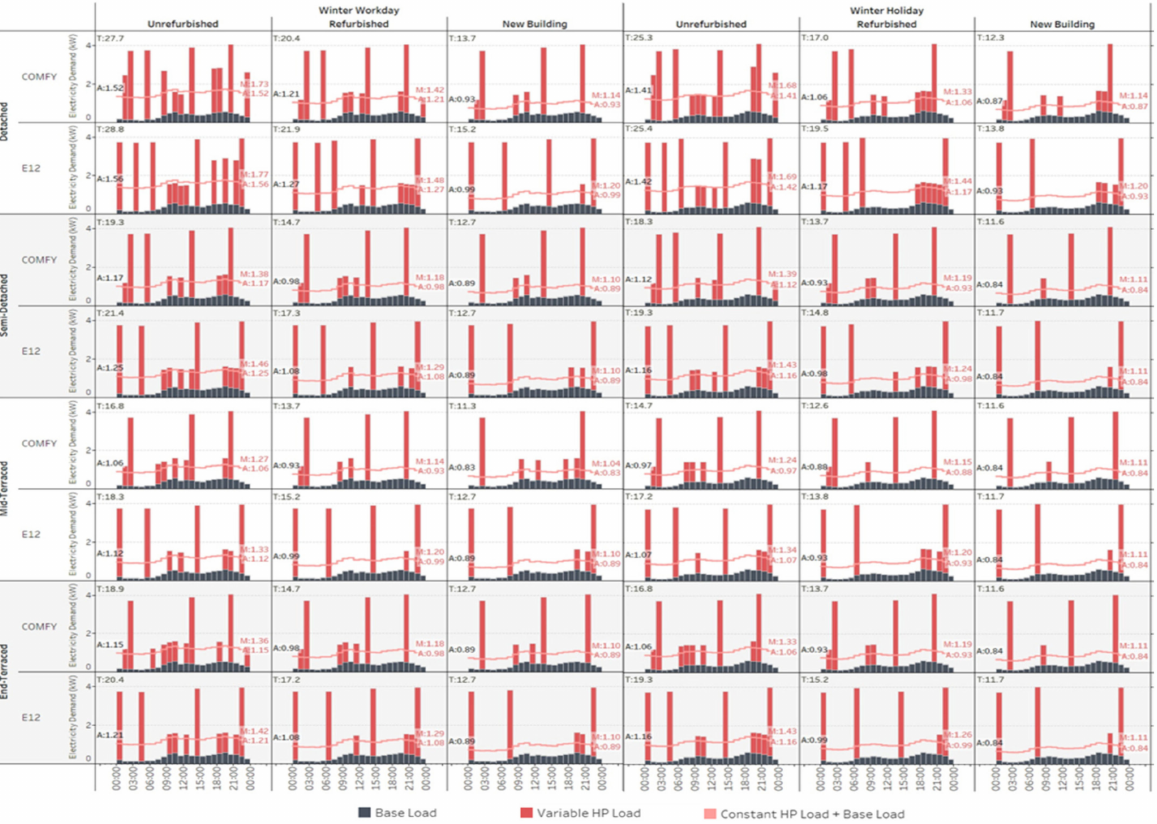
Figure 16. Average hourly electricity demand load curve of a representative heat pump profile by different archetypes and electricity tariffs for the coldest winter workday and holiday (T: Total, M: Maximum, A: Average).